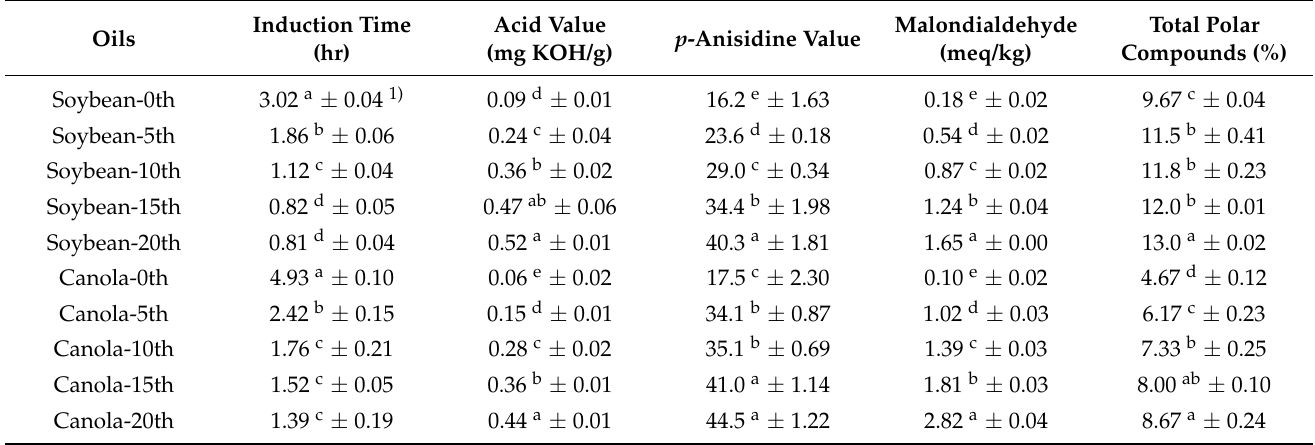
Table 1. Chemical properties of repetitively fried soybean and canola oils.